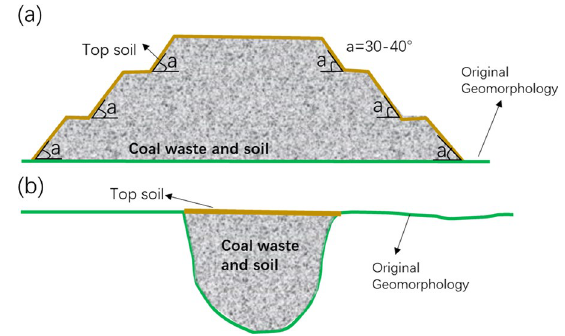
Fig. 1 Concept map of a Multi-stage dump, and b Gully filled